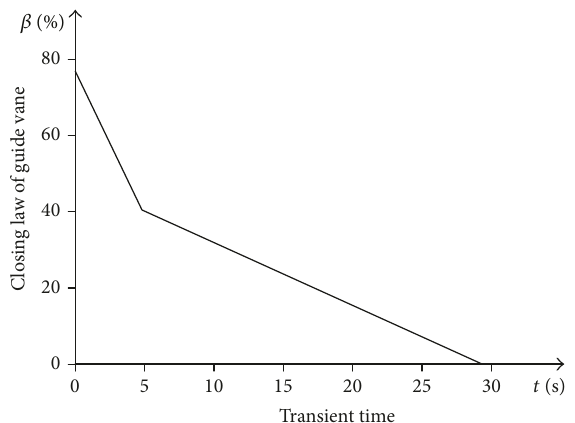
Figure 3: Closing law of an existing HGS in the load rejection transient process.